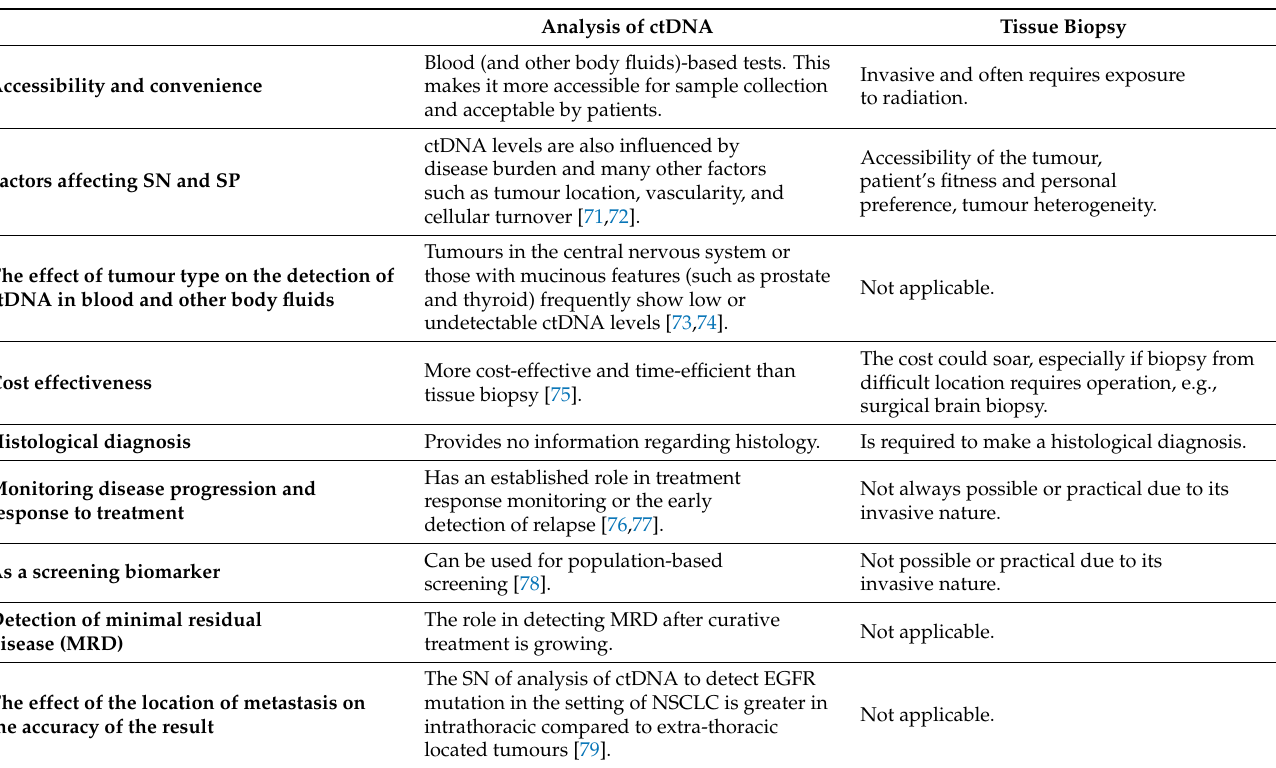
Table 2. Important differences between LB (analysis of ctDNA) and tissue biopsy. Analysis of ctDNA Tissue